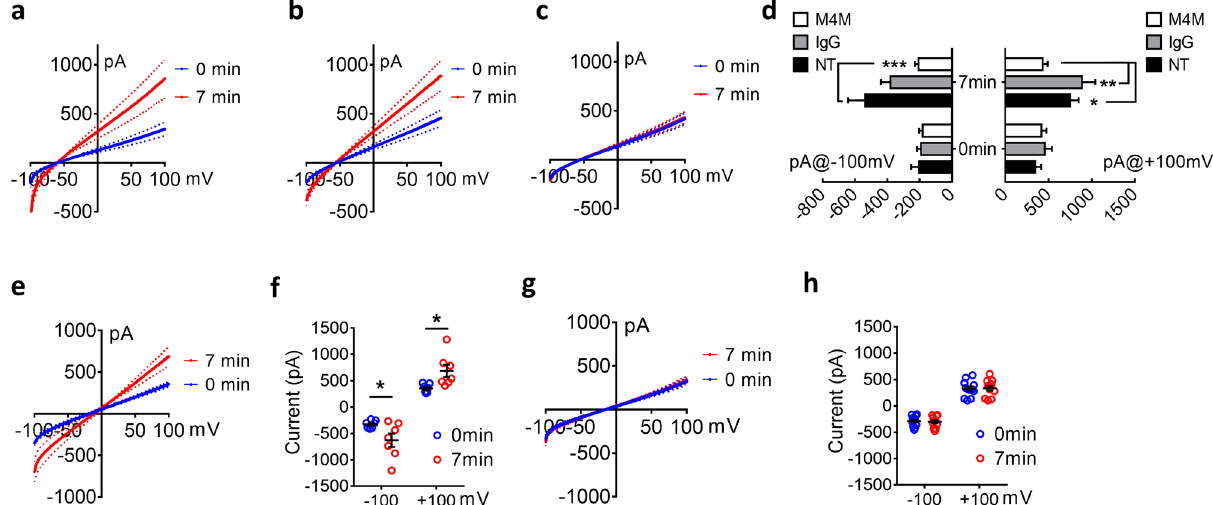
Figure 4. M4M blocks TRPM4 currents in cultured Human Brain Microvascular Endothelial Cells (HBMECs). ( a ) The current voltage relationships of TRPM4 from HBMECs before and after 7-min hypoxic induction. 250-ms voltage ramps from − 100 to + 100 mV was applied at 1 min interval with a holding potential of − 50 mV. Hypoxia was induced by adding 5 mM NaN3 and 10 mM 2-DG to the cells for 7 min. The data were presented as means ± s.e.m. ( b ) The current voltage relationships of TRPM4 from HBMECs pre-treated with control mouse IgG at a concentration of 20.8 μg/mL for 30 min. ( c ) The current voltage relationships of TRPM4 from HBMECs pre-treated with M4M at a concentration of 20.8 μg/mL for 30 min. ( d ) Summary of currents at − 100 mV and + 100 mV at 0 min before hypoxic induction and 7 min after hypoxic induction. For ( a – d ), Non-transfected group (NT): n = 11 cells; Control mouse IgG: n = 7 cells; M4M: n = 11 cells. ( e ) The current voltage relationships of HBMECs pre-treated with control mouse IgG with 0 mV holding potential. ( f ) Summary of currents at − 100 mV and + 100 mV at 0 min and 7 min. n = 7 cells. ( g ) The current voltage relationships of HBMECs pre-treated with M4M at 0 mV holding potential. ( h ) Summary of currents at − 100 mV and + 100 mV at 0 and 7 min. n = 12 cells. Statistical analysis in ( d , f , h ) were performed using Two-way ANOVA with Bonferroni’s post hoc test. *p < 0.05, **p < 0.01, ***p <